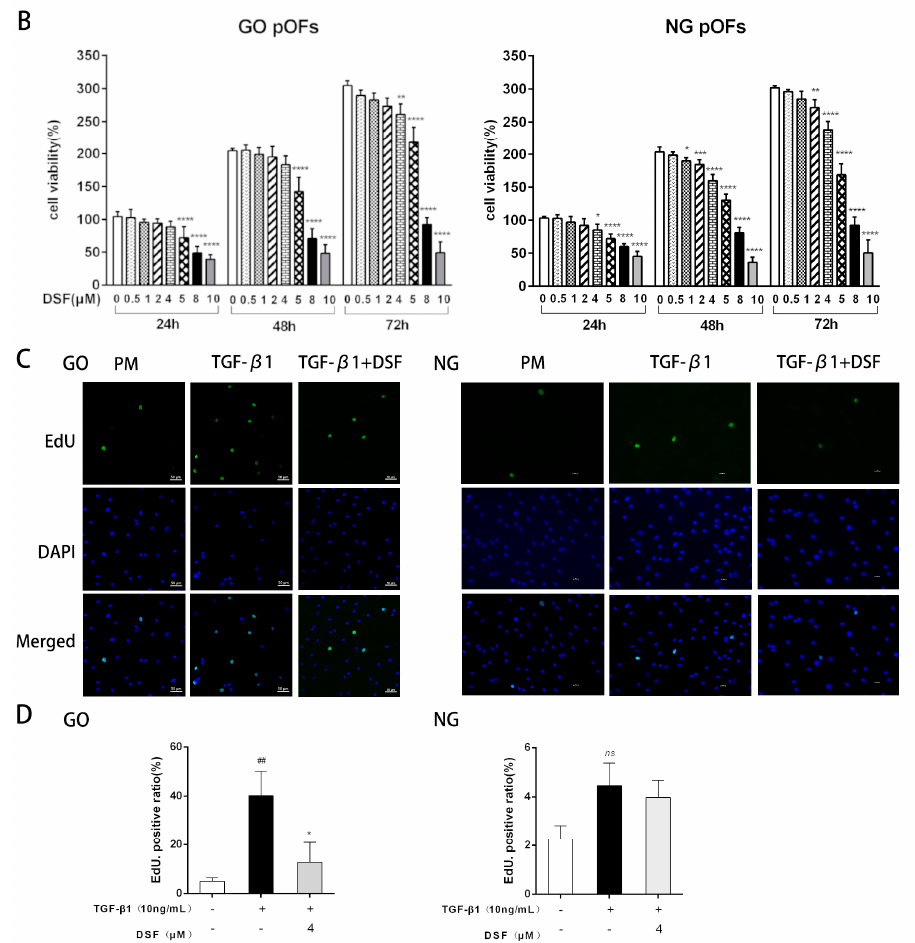
Figure 1. DSF inhibits TGF- β 1-induced cell proliferation in the pOF model of GO. ( A ) IF staining of pOFs with vimentin, CD90, cytokeratin, desmin, and S-100 antibodies (green). Cell nuclei were stained with DAPI (blue). The stained cells were examined under a fluorescence microscope (100 × ); scale bar = 100 µ m. ( B ) pOFs in the GO and NG groups were treated with increasing concentrations of DSF (0, 0.5, 1, 2, 4, 5, 8, and 10 µ M) in PM for 24 h, 48 h, and 72 h. Cell viability is presented as the percentage relative to the viability of the untreated cells. ( C ) Representative images of the EdU incorporation assay results in the pOFs in the GO and NG groups treated with TGF- β 1/DSF at the indicated concentrations. The cells were observed using a fluorescence microscope (200 × ), scale bar = 50 µ m. Green: EdU, blue: DAPI. ( D ) Quantification of the EdU incorporation assay results of the pOFs in the GO and NG groups (control, TGF- β 1 (10 ng/mL), TGF- β 1 + DSF (4 µ M)), n = 5. The data are expressed as the triplicates’ mean ± standard deviation (SD). ## p < 0.01 compared with the control; * p < 0.05, ** p < 0.01, *** p < 0.001, and **** p < 0.0001 compared with TGF- β 1 alone; ns denotes no statistical significance versus the control/TGF- β 1; assessed by one-way